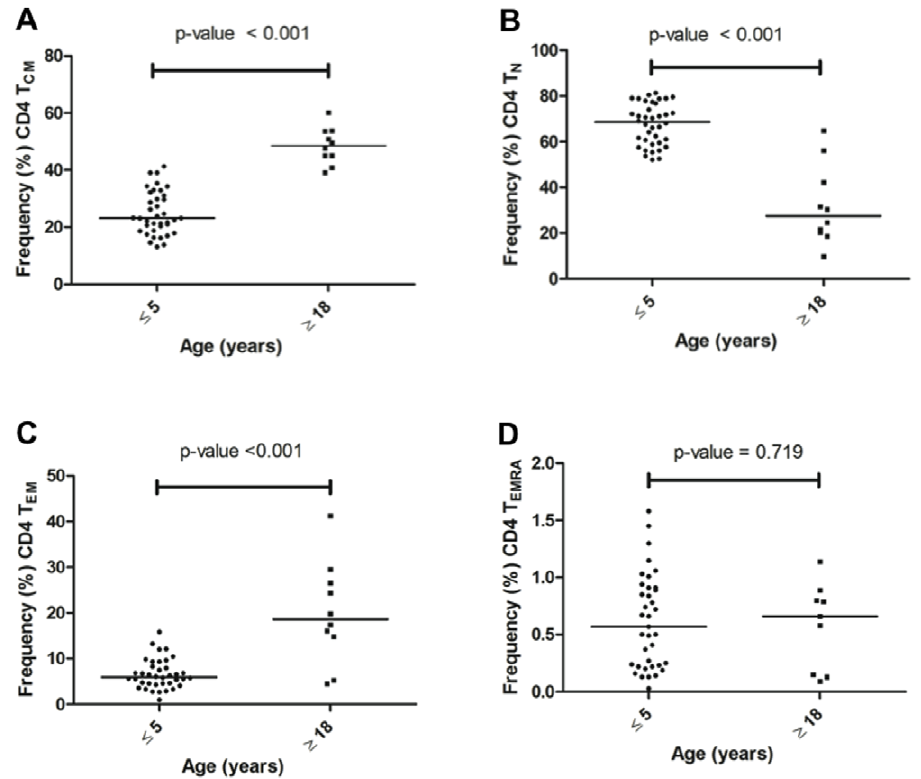
Figure 3. Proportion of resting CD4 T cell subsets across age groups. The frequency of each T cell subset was compared between adults ( $ 18 years old) and children ( # 5 years old) for ( A ) Central memory, T CM : CD4 + CD45RA 2 CD62L + ; ( B ) naı¨ve T cells, T N : CD4 + CD45RA + CD62L + ; ( C ) effector memory, T EM : CD4 + CD45RA 2 CD62L 2 ; and ( D ) RA-expressing effector memory, T EMRA : CD4 + CD45RA + CD62L 2 . The median frequency of CD4 + T CM and T EM was significantly lower for children compared to adults ( P , 0.001, Mann Whitney test). Whereas the median frequency of CD4 + T N was significantly higher for children compared with adults ( P , 0.001). The median frequency of CD4 + T EMRA was similar for the two age groups ( P =0.719).